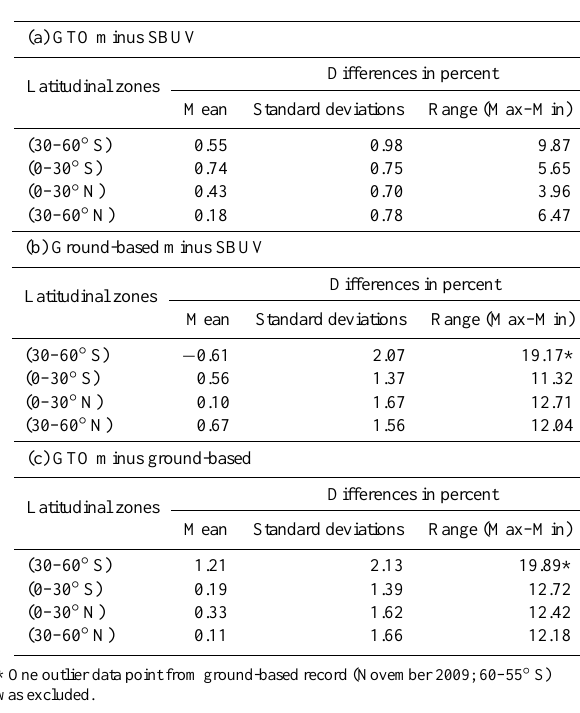
Table 3. Summary of the differences in monthly zonal mean total